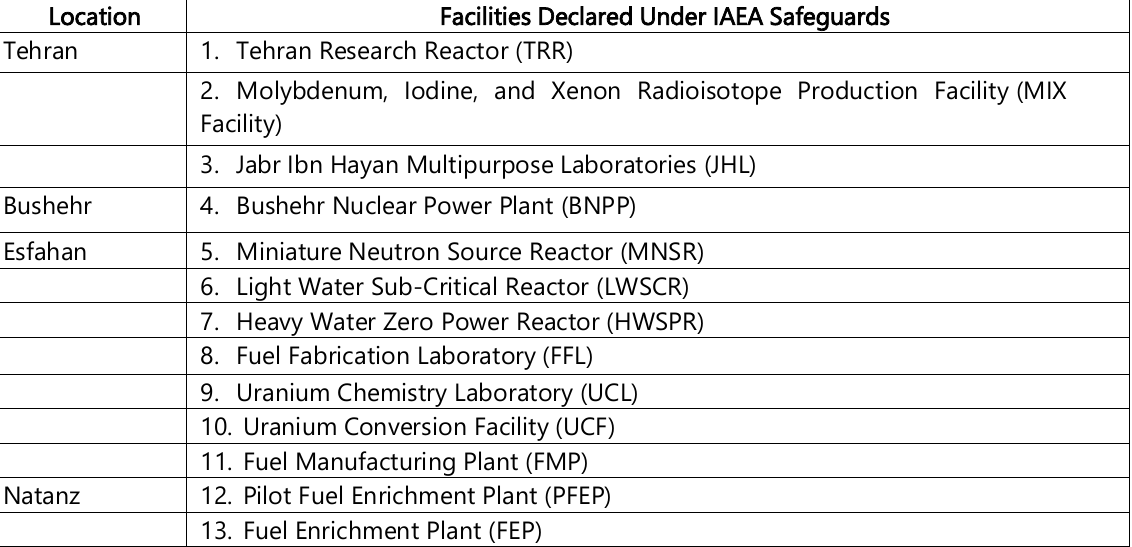
Table 1: List of Iran‟s Nuclear Facilities Under IAEA Safeguards (2014) (Source: IAEA (GOV/2014/10)